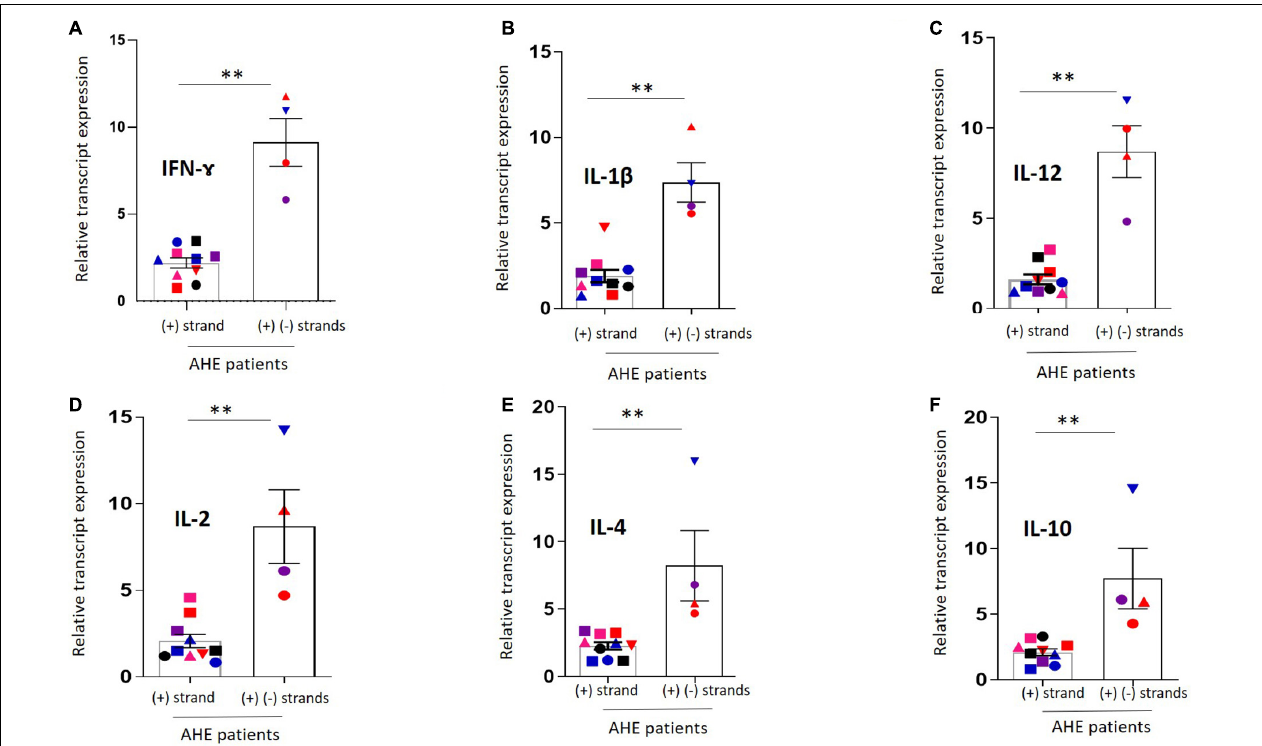
FIGURE 3 | Comparison of the cytokine transcripts between PBMCs with detectable ( + ) and (–) RNA strands vs. PBMCs with detectable ( + ) RNA strand. (A–F) The immune transcripts including IFN- G (A) , IL-1 β (B) , IL-12 (C), IL-2 (D) , IL4 (E) , and IL-10 (F) were compared between PBMCs with detectable ( + ) and (–) RNA strands ( n = 4) versus PBMCs with the detectable ( + ) RNA strand only ( n = 10). Data represented as mean ± SEM. ** indicates p < 0.01 as determined by Mann–Whitney